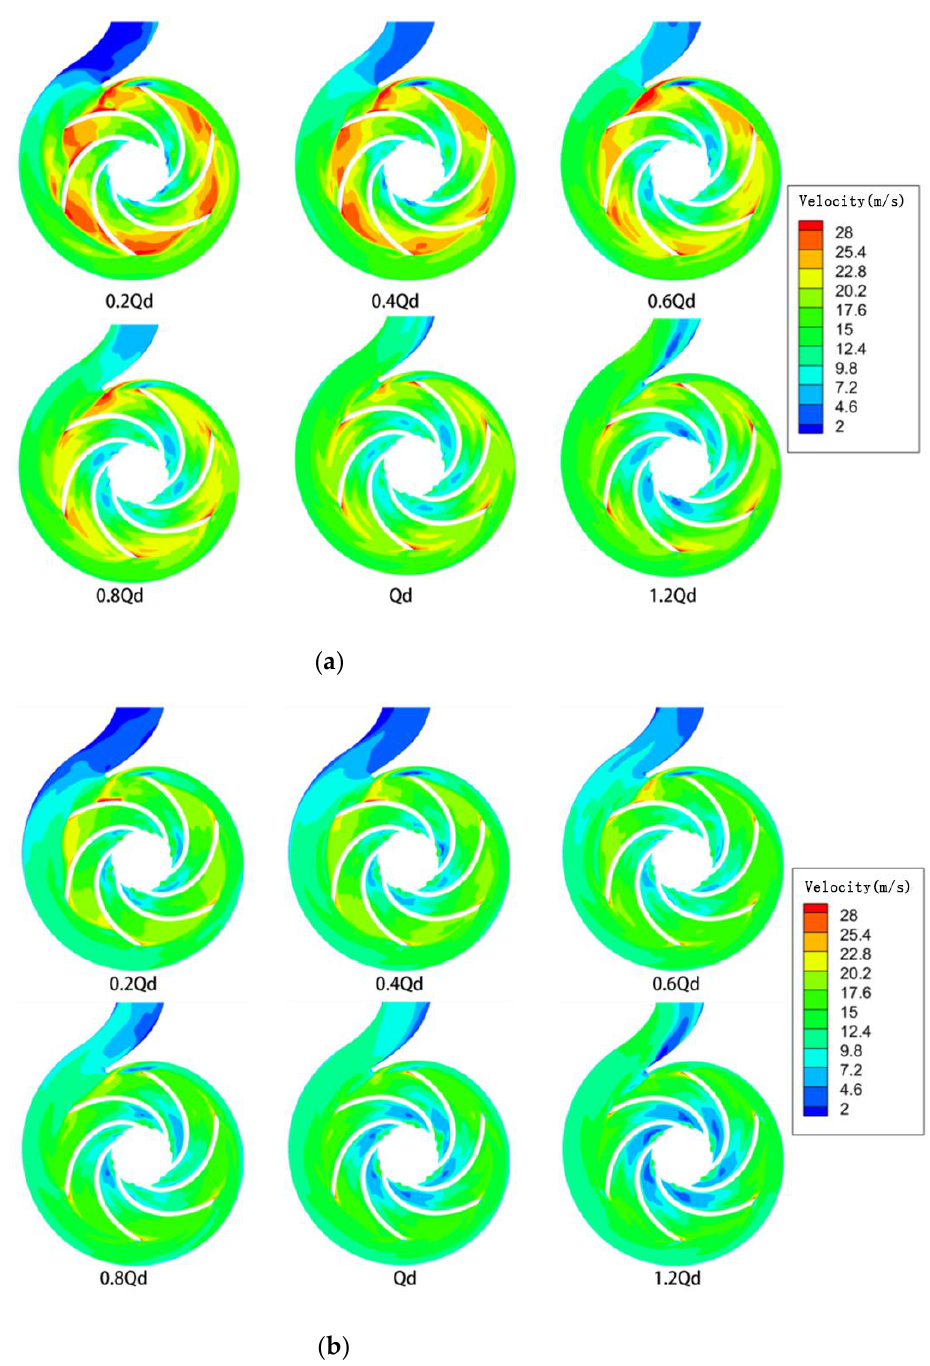
Figure 14. Velocity contours in the centrifugal pump. ( a ) Cases with water; ( b ) cases with drilling fluid.